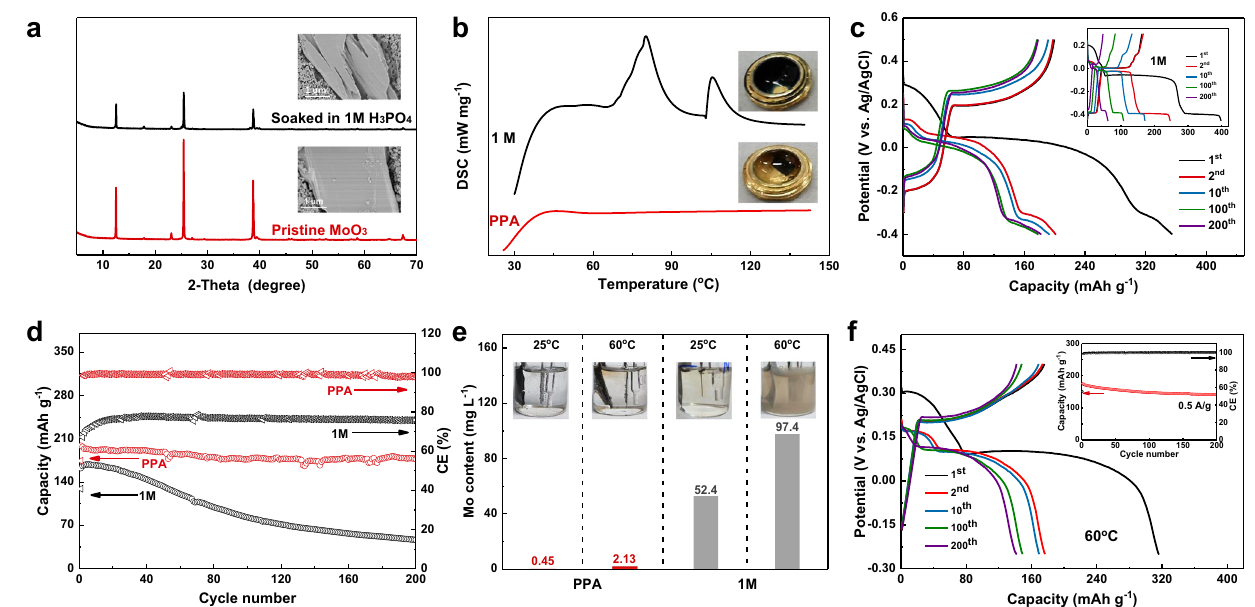
Fig. 2 | Characterization investigations and electrochemical performance of MoO 3 anode. a XRD patterns of the pristine MoO 3 electrode and MoO 3 electrode soakedin1MH 3 PO 4 for5days. b DSCforthemixtureof MoO 3 membraneandPPA (or1MH 3 PO 4 ). c , d Thecomparisonofvoltagepro fi lesandcyclingperformanceof